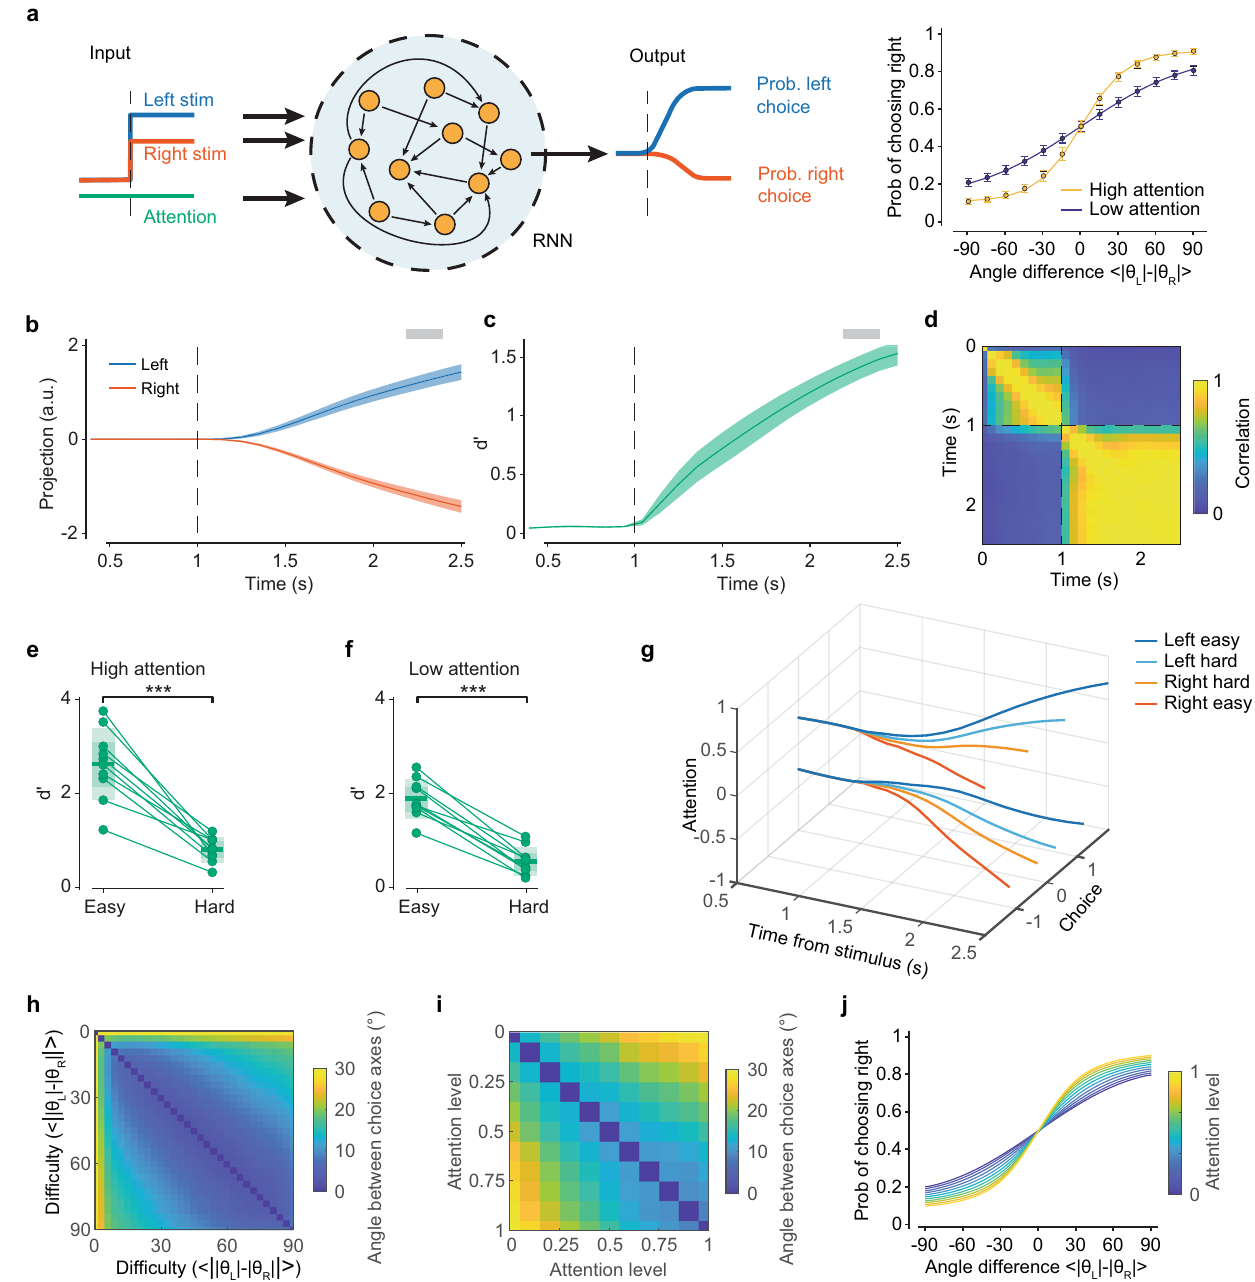
Fig. 5 | RNN model relates neural representations to DM computations. a Left: recurrent neural network (RNN) architecture consisting of a module with N =50 recurrently connected units. The module receives two inputs for the left and right stimuli, and one input for the attentional state. It generates a continuous output that will determine the choice. Right: Target psychometric curves — matching the animals ’ psychometric responses — usedto determine the proportionofL/R-choice trials in the training set for each dif fi culty level, depending on the attention state. Data showing meanand its 95%CIacross n =200trained networks. b Projection of left and right trials onto the choice state-axis following the same methods used in Fig.2.Shadedbaratthetopdenotestheselectedtimeusedforstate-axisaveraging (line for trial average and shaded area for its 95% CI for a representative network). c Evolution of choice axis discriminability over time (line for average across and shaded area for its s.e. across n =10 networks). d Cross-correlogram of choice axis